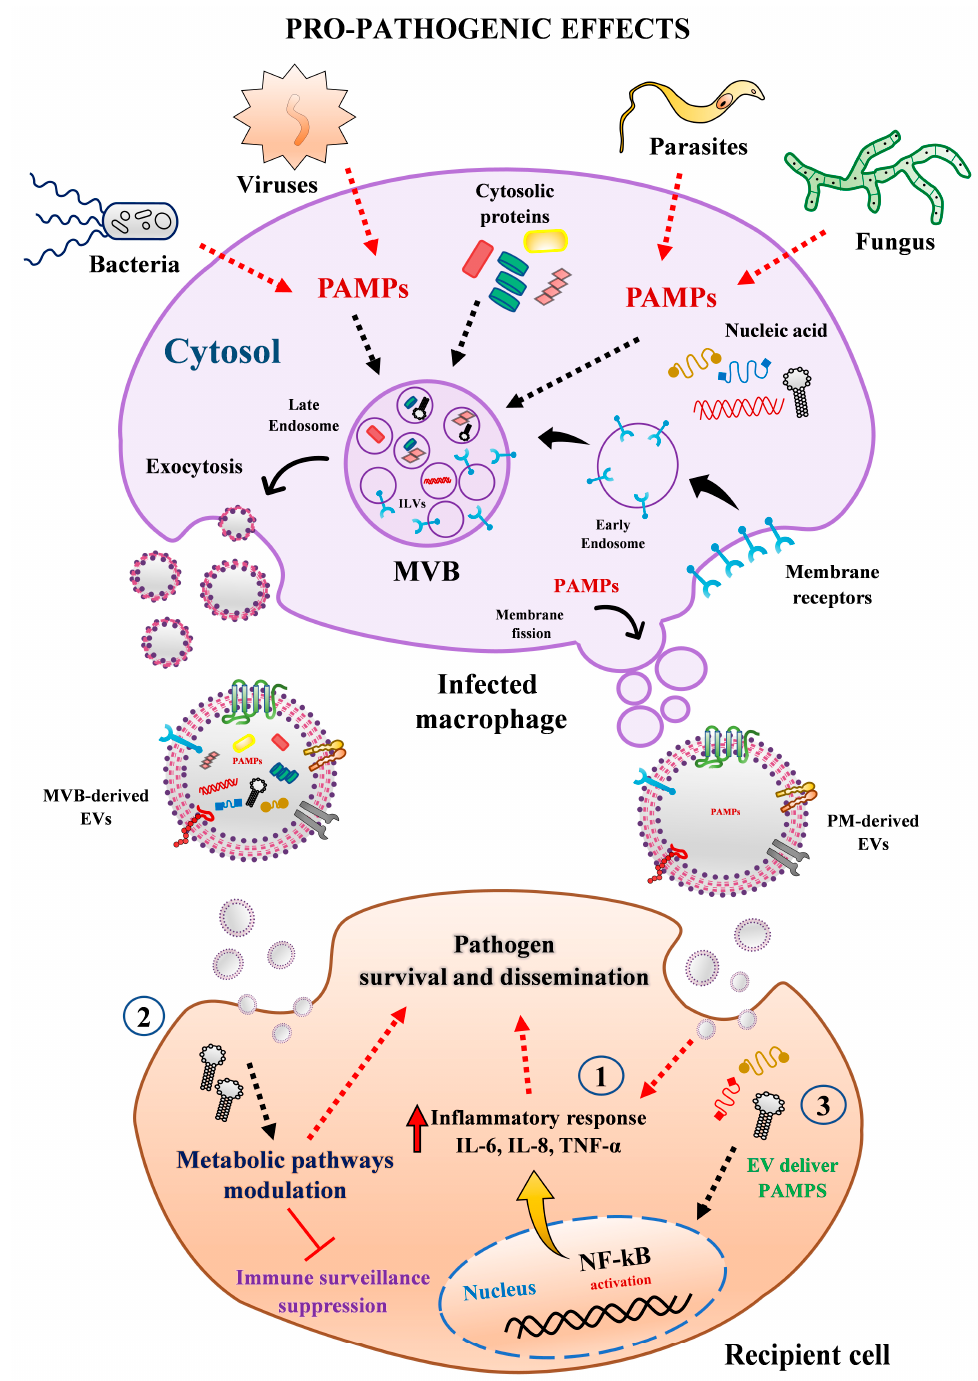
Figure 3. Pro-pathogenic effect mediated by EVs released from human macrophages. Macrophages infected with bacteria, virus, parasite, or fungi secreted heterogenous populations of EVs from different origin and sizes, which may favor pathogen growth and propagation through multiple mechanisms. For instance, (1) EVs from infected cells can trigger the secretion of pro-inflammatory cytokines (e.g., IL-6, IL-8, TNF- α ) in recipient cells via activation of NF-kB pathway. (2) M Φ -EVs from infected cells can reprogram recipient cell metabolism pathways and modulated immune surveillance through transferring specific miRNAs. (3) EVs can be exploited by pathogens as alternative strategy to export microbial components (e.g., proteins, RNAs, miRNAs) to impair host defense and promote their infectivity and propagation. Abbreviations: MVBs, multivesicular bodies; PAMPs, pathogen-associated molecular patterns; PM, plasma membrane.